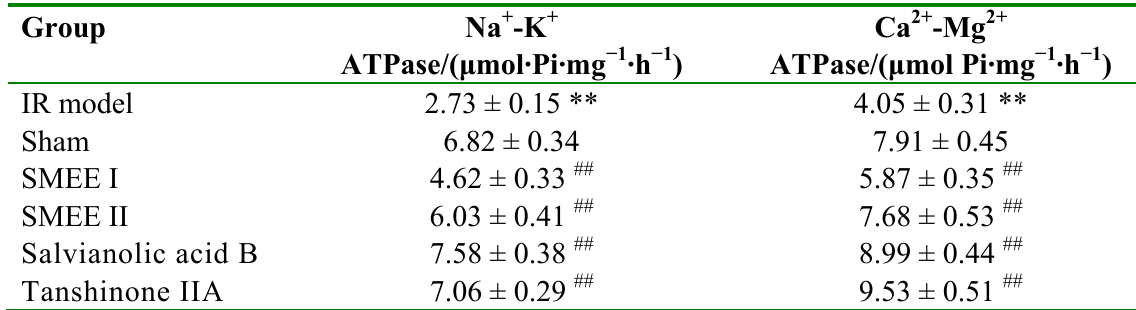
Table 4. Effect of S. miltiorrhiza ethanol extract on the myocardium Na + -K + ATPase and Ca 2+ -Mg 2+ ATPase activities.